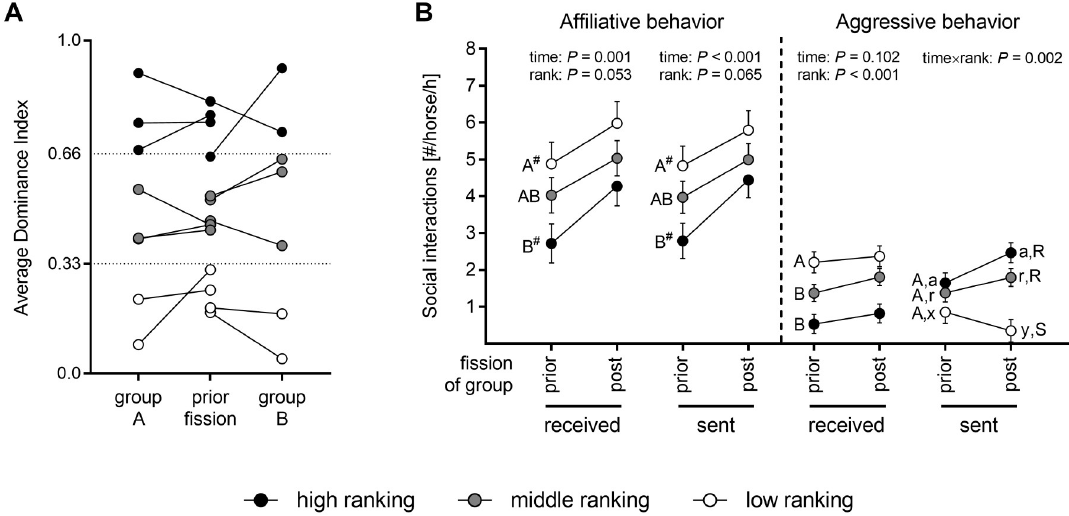
Fig 5. Fission of a stable group does not change the rank class of individual horses but induces higher numbers of affiliative interactions. (A) Average dominance index of individual horses before and after fission of a stable group. Individual horses are depicted by circles. ADI of 0–0.33 = low ranking, 0.34–0.65 = middle ranking, 0.66–1.0 = high ranking horses; (B) Number of received and sent affiliative and agonistic interactions per horse and hour before and after fission of a stable group. Interactions are depicted as LSmeans ± SE (in case of overlapping SE only one direction is shown) for each rank class separately. Results of linear mixed model analyses are depicted within the graph sparing result of time × rank interaction if P > 0.05, or results of single effects of time and rank if time × rank interaction with P < 0.05. In case of missing effect of time × rank interaction: Different uppercase depict significant differences ( P < 0.01) and different uppercases marked by # depict statistical trend ( P < 0.1) between rank classes irrespective of point in time. In case of significant effect of time × rank interaction: Different uppercases depict significant differences ( P < 0.001) of rank at particular point in time (prior to fission: A-B, post fission: R-S) and different lowercases depict significant differences ( P < 0.05) between points in times of particular rank class (high ranking: a-b, middle ranking: r-s, low ranking: x-y); N = 15; black circles = high ranking horses (N = 5), gray circles = middle ranking horses (N = 6), white circles = low ranking horses (N = 4).